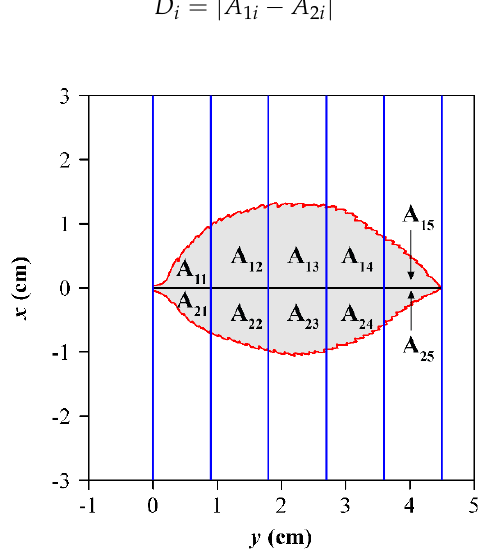
Figure 1. Illustration of the measure of bilateral symmetry for a leaf of Prunus cerasifera f. atropurpurea . The leaf base is on the left, and the leaf apex is on the right. For convenience, only five equidistant strips are shown. In practice, we used 1000 equidistant strips intersecting the leaf to calculate the mean and variance of the absolute differences between A i 1 and A i 2 , where i ranges from 1 to 1000.